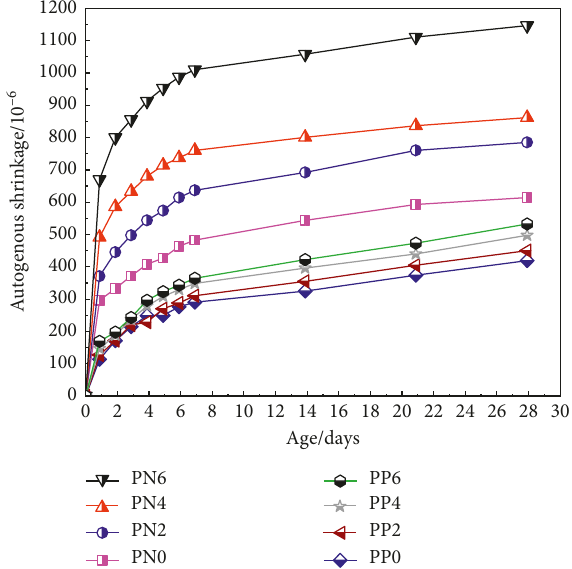
Figure 9: The autogenous shrinkage strain of plastic mortar vs curing